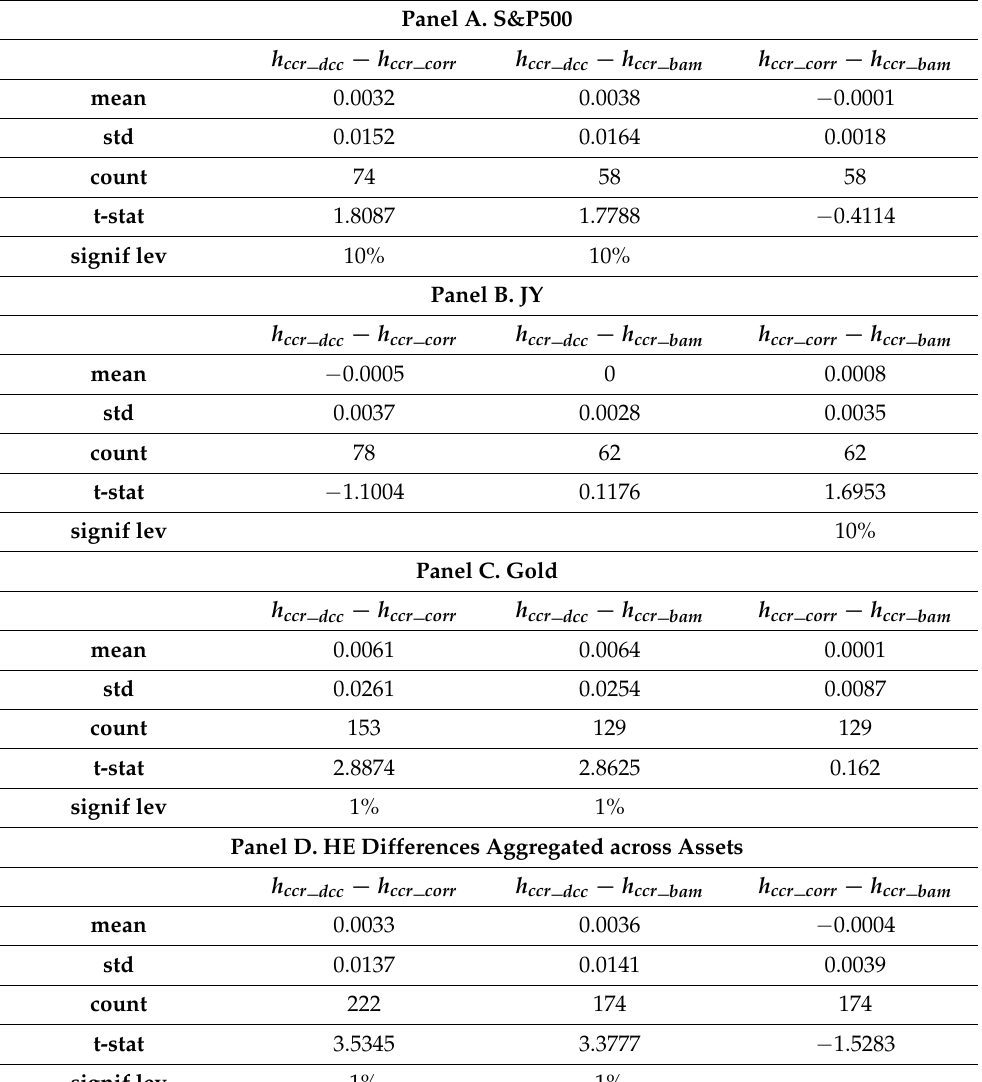
Table 4 directly tests the HE differences across the various bias-adjusted h ccr ap- proaches. The HE is statistically significantly higher for h ccr_dcc than it is for the other bias-adjustment approaches for the individual assets (other than for the JY) and for the aggregation across assets. Table 4. Hedge Effectiveness Differences across h ccr Bias-Adjustment